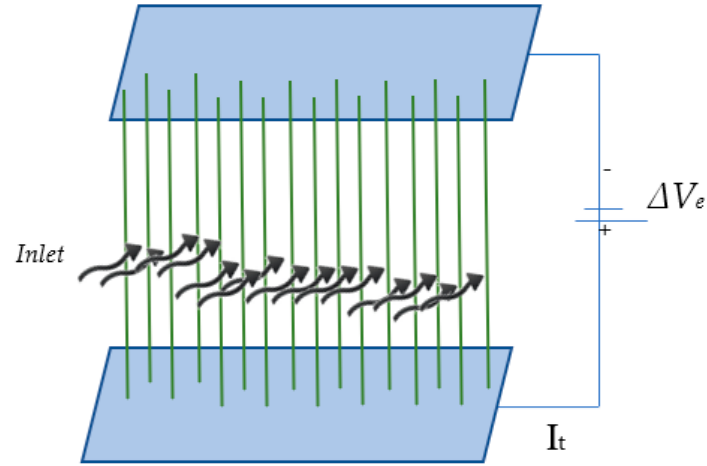
Figure 6. Parallel wires unit reactor configuration. Adapted from [105].